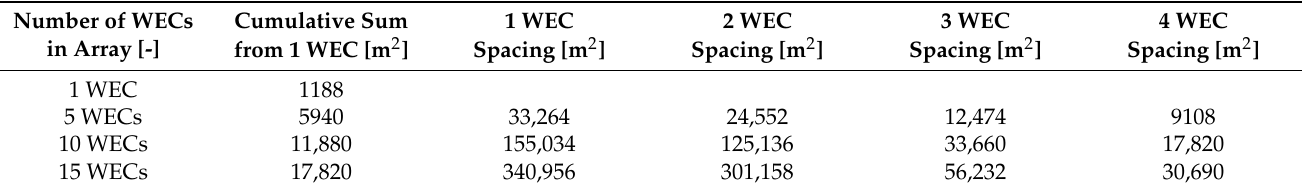
Table 2. Comparison of different WEC array sizes and their spatial area of influence. The predicted cumulative sum of the influence from one WEC is compared for multiple WECs with a variety